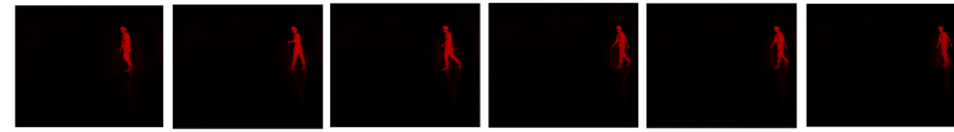
Figure 2. Gait Data Obtained after Pre-Processing and Gait Cycle Detection [92].